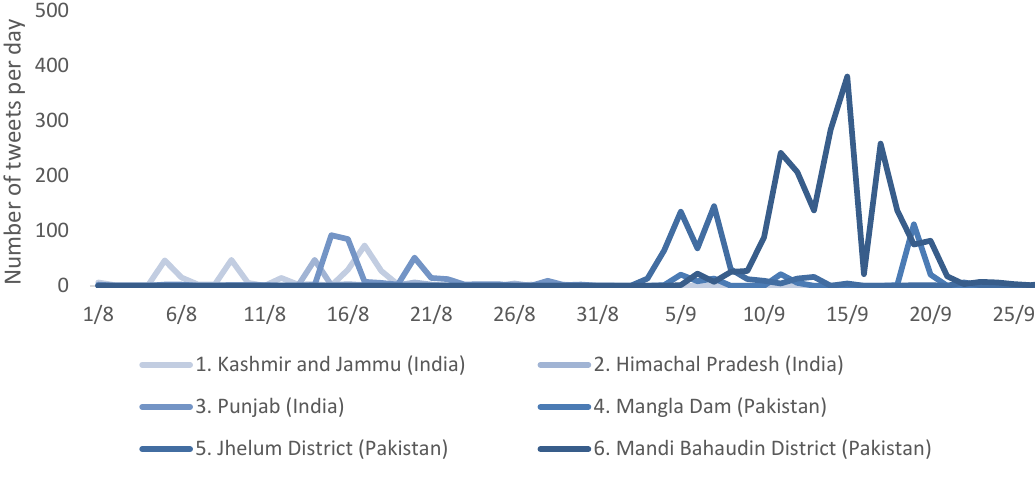
Figure 7. Tweet count related to dams and barrages, along the Jhelum, Chenab, and Ravi rivers. The locations are roughly ordered from upstream to downstream (numbered 1 to